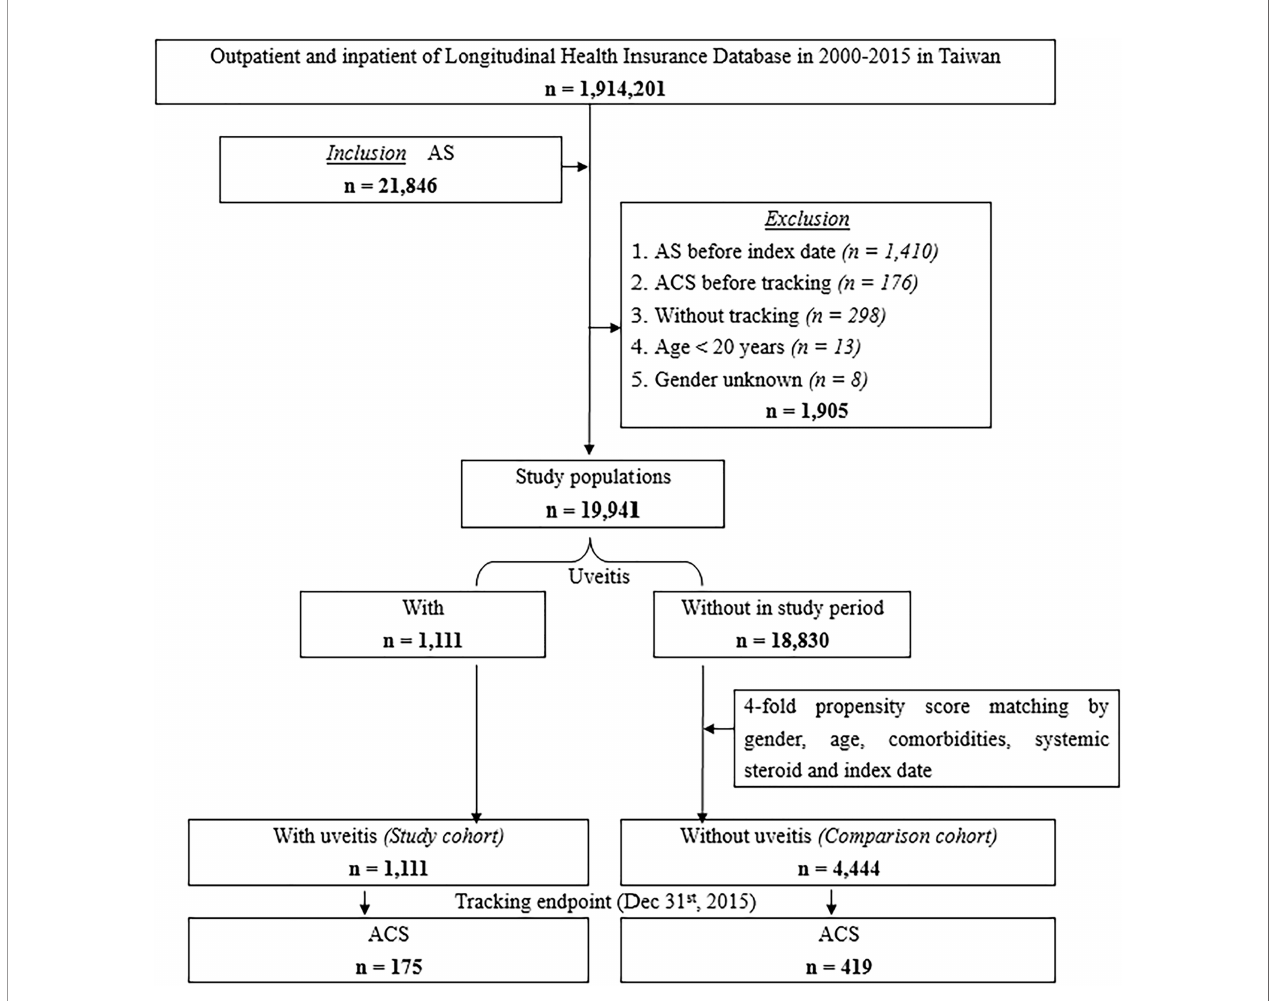
FIGURE 1 | Flowchart of the study